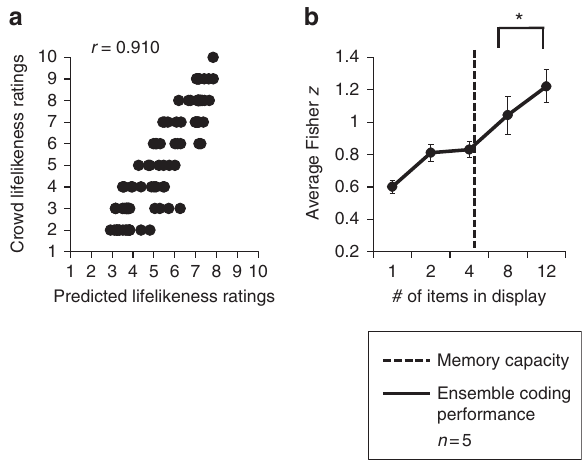
Figure 8 | Results of Experiment 6. ( a ) Crowd lifelikeness of large groups is well predicted by the average of individual item ratings from independent observers. This graph depicts the ratings (black circles) of one representative participant judging 102 unique temporal groups. There is a high Pearson correlation, r ¼ 0.910 between the ratings of average crowd lifelikeness ( y axis) and predicted ratings of the groups generated from single-item ratings ( x axis). ( b ) Averaged data for five observers. The x axis represents the number of items displayed in the set. The y axis represents the magnitude of the Fisher z score. The Fisher z score in the whole set condition indicates that participants are able to perceive ensemble lifelikeness even in large groups of items (in this case 12 items). The Fisher z scores increase as the number of items displayed increases. This pattern rules out the possibility that participants engaged in random subsampling techniques to accomplish the task. Error bars represent s.e.m. Finally, the dashed line represents the memory capacity limit in this experiment. Participants remembered on average five items in each display. However, their ensemble coding performance continued to significantly increase between 8 and 12 items, indicating that ensemble coding performance is not solely dependent on explicitly remembered